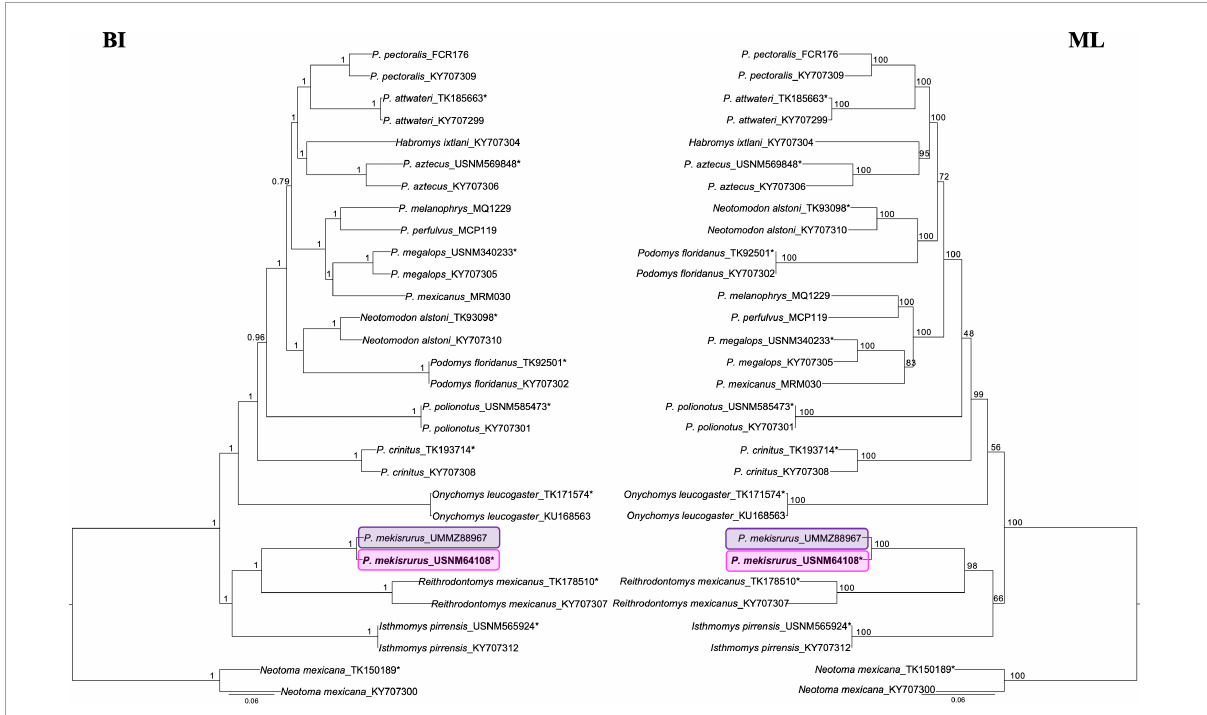
FIGURE3 Mitogenome phylogenies based on Bayesian Inference (BI) and Maximum Likelihood (ML). Nodal support is provided with posterior probability and bootstrap values, respectively. The pink block highlights the phylogenetic position of the Peromyscus mekisturus holotype collected in 1898, and the purple block shows the position of the second specimen collected in 1947. Asterisks* denote specimens that were sequenced from museum specimens for this study and compared with previous GenBank accessioned mitogenome sequences.